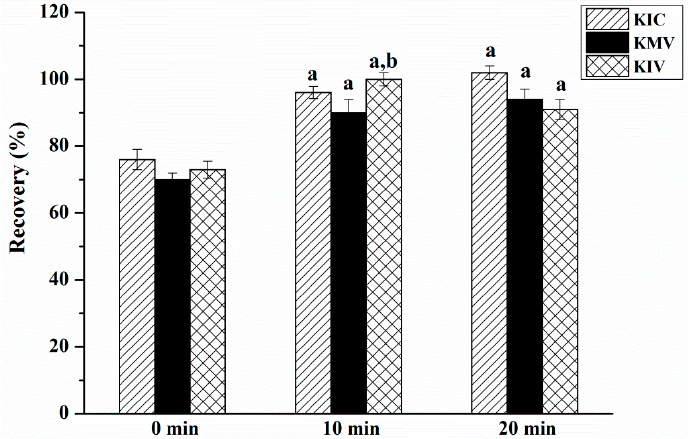
Figure 4. The influence of different ultrasonic time on the recoveries of three BCKAs (KIV: α -ketoisovalerate; KMV: α -keto- β -methylvalerate; KIC: α -ketoisocaproate). a , b Means the same compounds different significantly ( p < 0.05).